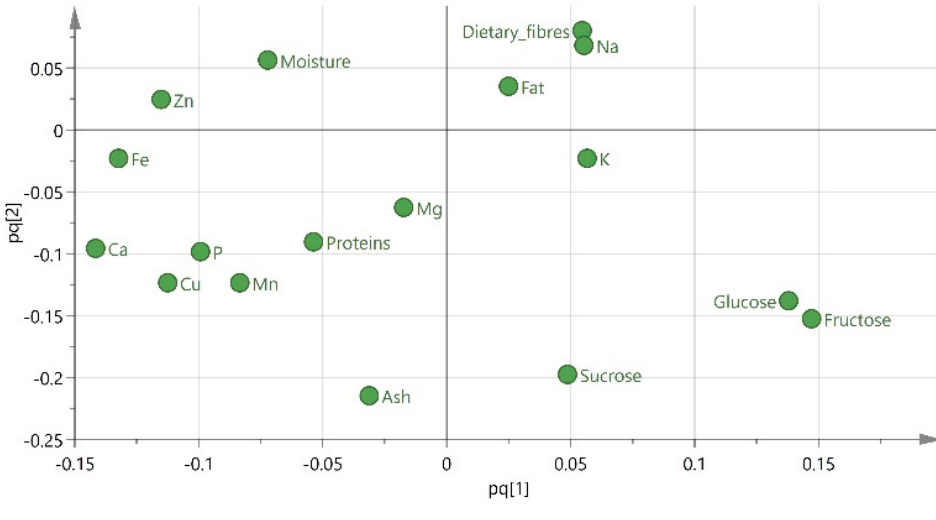
Figure 4. Loading score plot of the OPLS model.